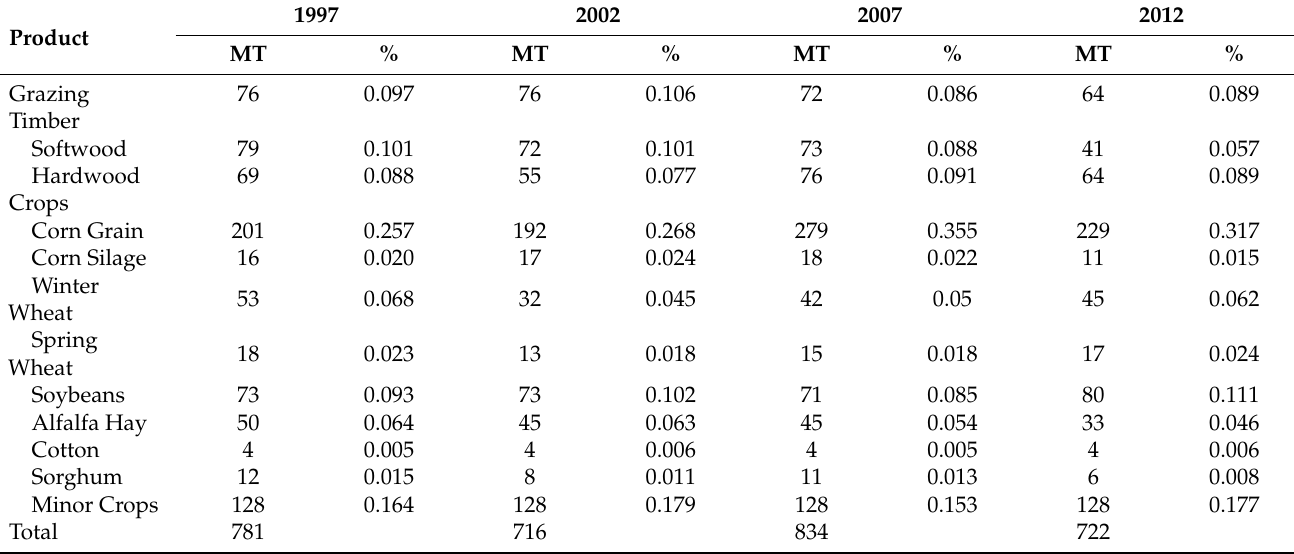
Table 1. U.S. HANPP in megatons (MT) and as a percentage of total HANPP. These values are derived from specific products in 1997, 2002, 2007,